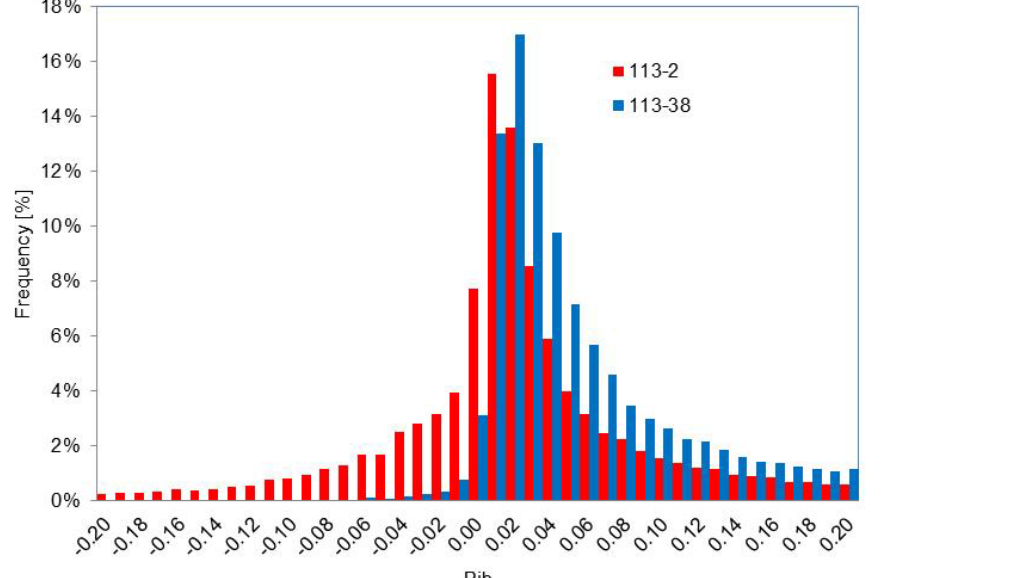
Figure 11. Probability distribution of Ri b measured between 2 and 113m (red one) and between 38 and 113m (blue lines). Only concurrent time steps between July 2014 and June 2015 are